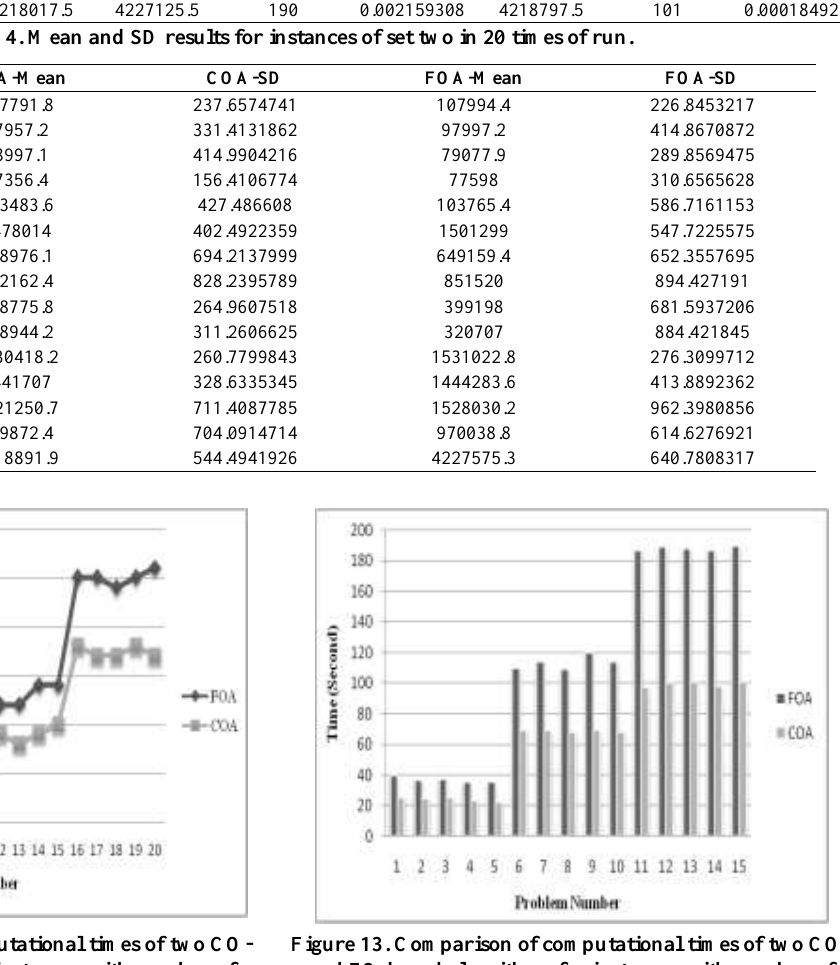
Table 4. Mean and SD results for instances of set two in 20 times of run.